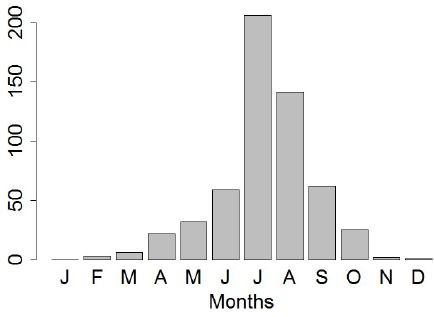
Figure 2. Total number of stated WR decisions over the RM district per month over the period